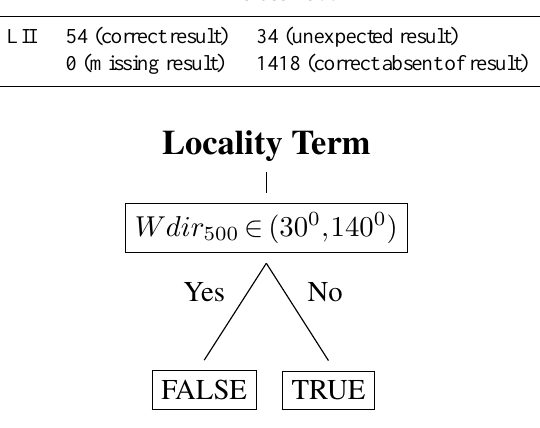
Figure 6. Schematic diagram of the locality Fig. 5. Schematic diagram of the Terrain Heating Effect Term Fig. 6. Schematic diagram of the Locality Term Figure 4. Schematic diagram of the moisture term.